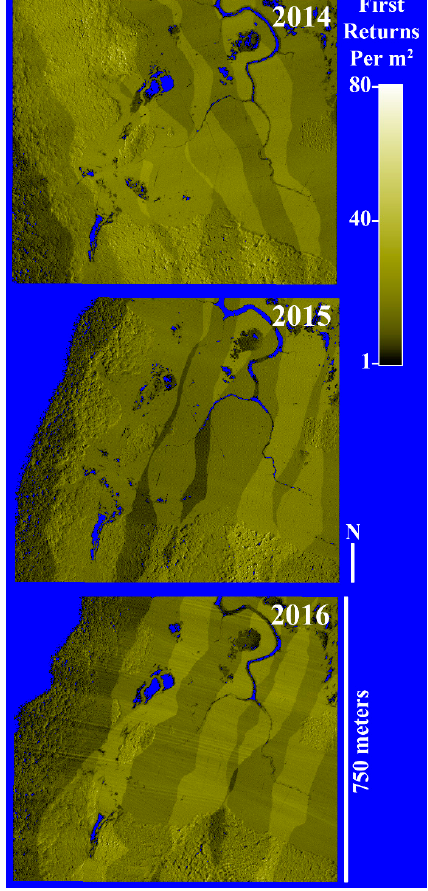
Figure 19. Densities of first returns (1 m resolution) for the 2014-2016 airborne lidar